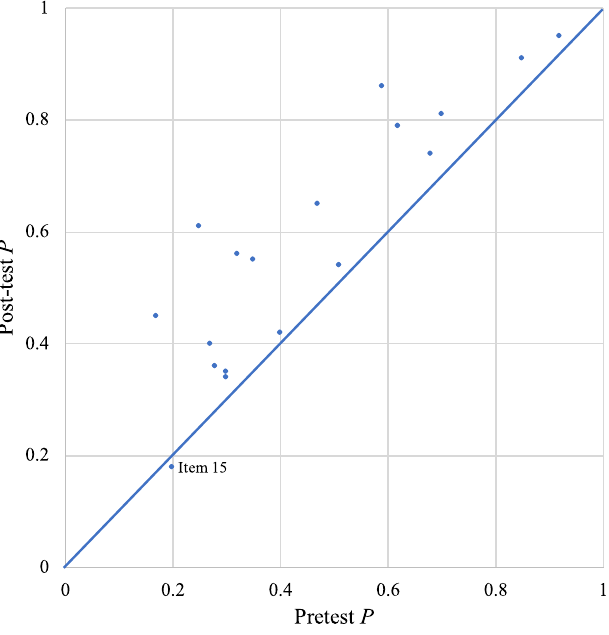
FIG. 5. Pretest item difficulty ( P ) versus post-test, as reported in Table V. Item difficulty values are higher in the post-test for all items in the MPCI-MS (i.e., a larger number of students answered the items correctly), except for item 15, which lie below the diagonal line representing equal pre- and